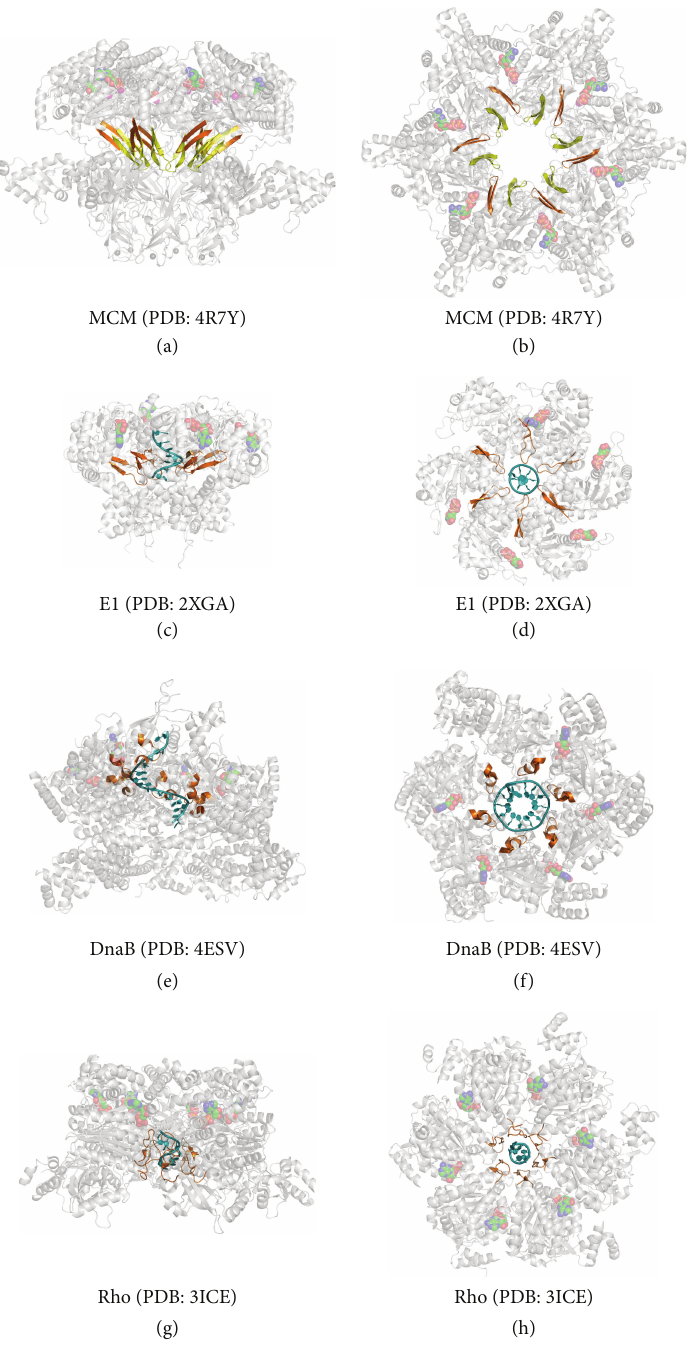
Figure 7: Comparison of MCM with representative members of other hexameric helicase superfamilies. The hexameric MCM structure viewed either perpendicular (a) or parallel (b) to the central channel axis. The MCM h2i and ps1 𝛽 central channel modules are colored yellow and orange, respectively. (c–h) Comparison with representative members of other helicase superfamilies such as E1 ((c-d), SFIII, PDB: 2XGA), DnaB ((e-f), SFIV, PDB: 4ESV), and Rho ((g-h), SFV, PDB: 3ICE) suggests that MCM central channel modules will move “up” and “down” to translocate DNA. In the crystal structures of each of these hexameric helicases, basic residues on loops projected into the central channel interact with nucleic acid in a spiral-staircase-like arrangement. In this mode of binding, the central channel loops from adjacent subunits occupy different heights around the ring to form a “spiral-staircase” shape. The movement of DNA is then achieved by the movement of the central channel loops. DNA is colored in teal and DNA binding loops are colored orange. All structures are viewed either perpendicular (left column) or parallel (right column) to the central channel axis. All structure representations of Figure 7 were prepared with the Pymol software package